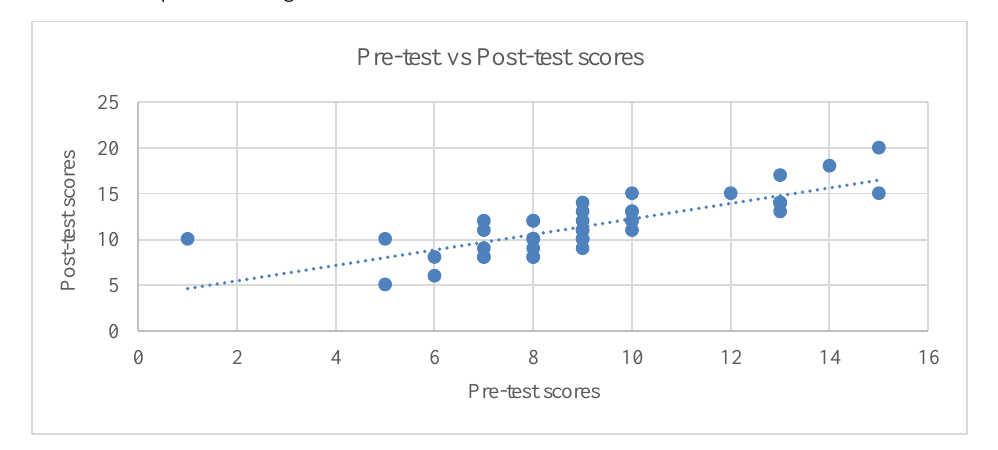
Figure 2 : Scatterplot of Test Scores Achieved in Pre-Test and